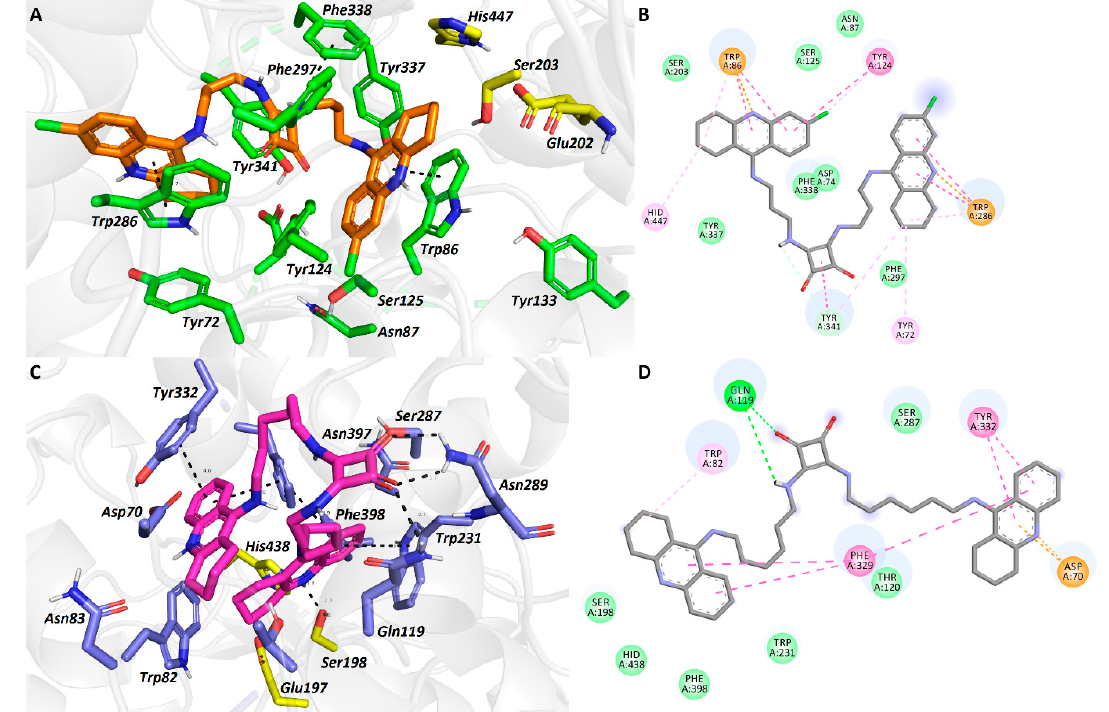
Figure 3. Docking results for the tacrine-squaramide hybrids 4b and 3e within h AChE ( A , B ) and h BChE ( C , D ) active sites, respectively (PDB IDs: 4EY7, 4BDS). A and C—Superimposed analogues 4b and 3e (orange and purple carbon atoms, respectively) as 3D figures; B and D—2D figures 4b and 3e , respectively. Generally to A and C—important amino acid residues involved in the ligand-enzyme interactions are displayed as green and blue carbon atoms, respectively; catalytic triad residues are shown in yellow, the rest of the enzyme is represented as a light-grey cartoon. Figures A and C were generated with PyMol 1.5.0.4 (The PyMOL Molecular Graphics System, Version 1.5.0.4 Schrödinger, LLC, Mannheim, Germany), Figures B and D were created with Discovery Studio 2016 Client